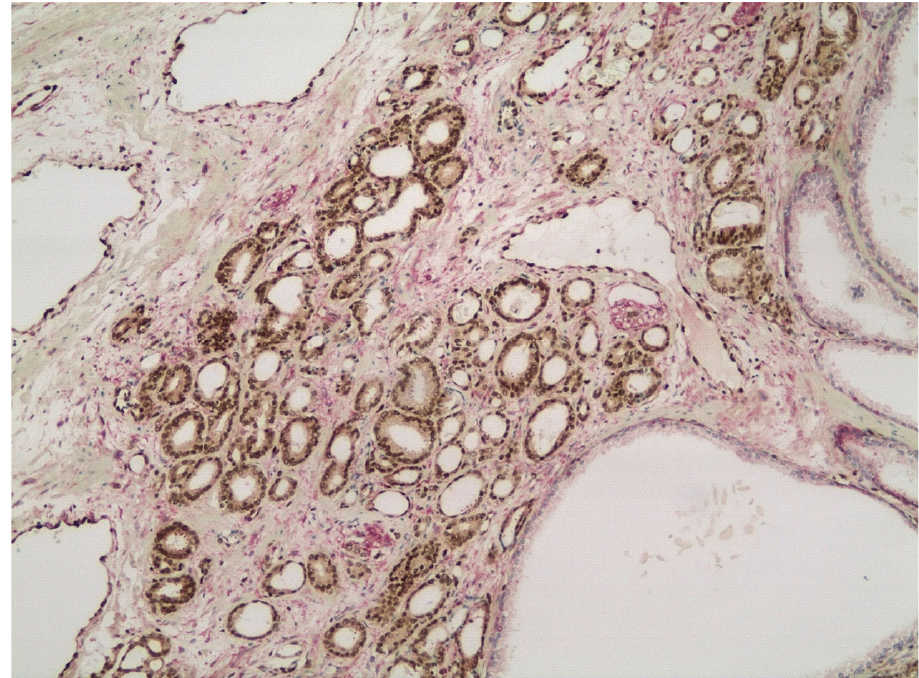
Figure 4. ERG nuclear immunopositivity in prostate acinar adenocarcinoma of Gleason grade pattern 3 (×100).